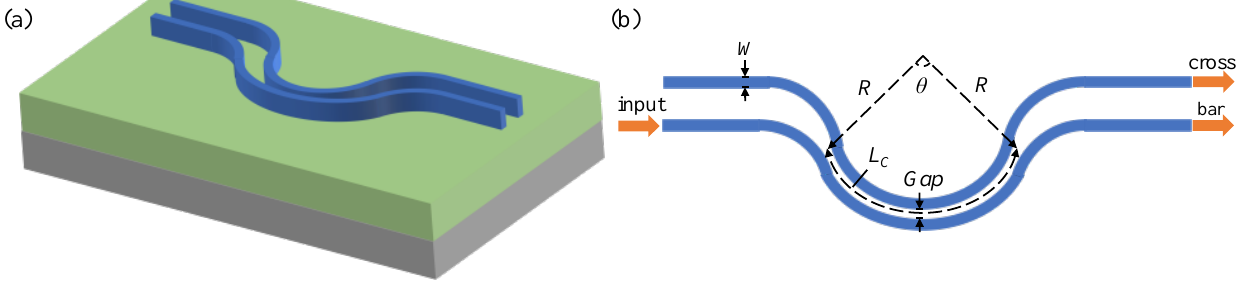
Figure 1. Schematic structure of the bent DC: ( a ) 3D sketch; ( b ) top view and design parameters.